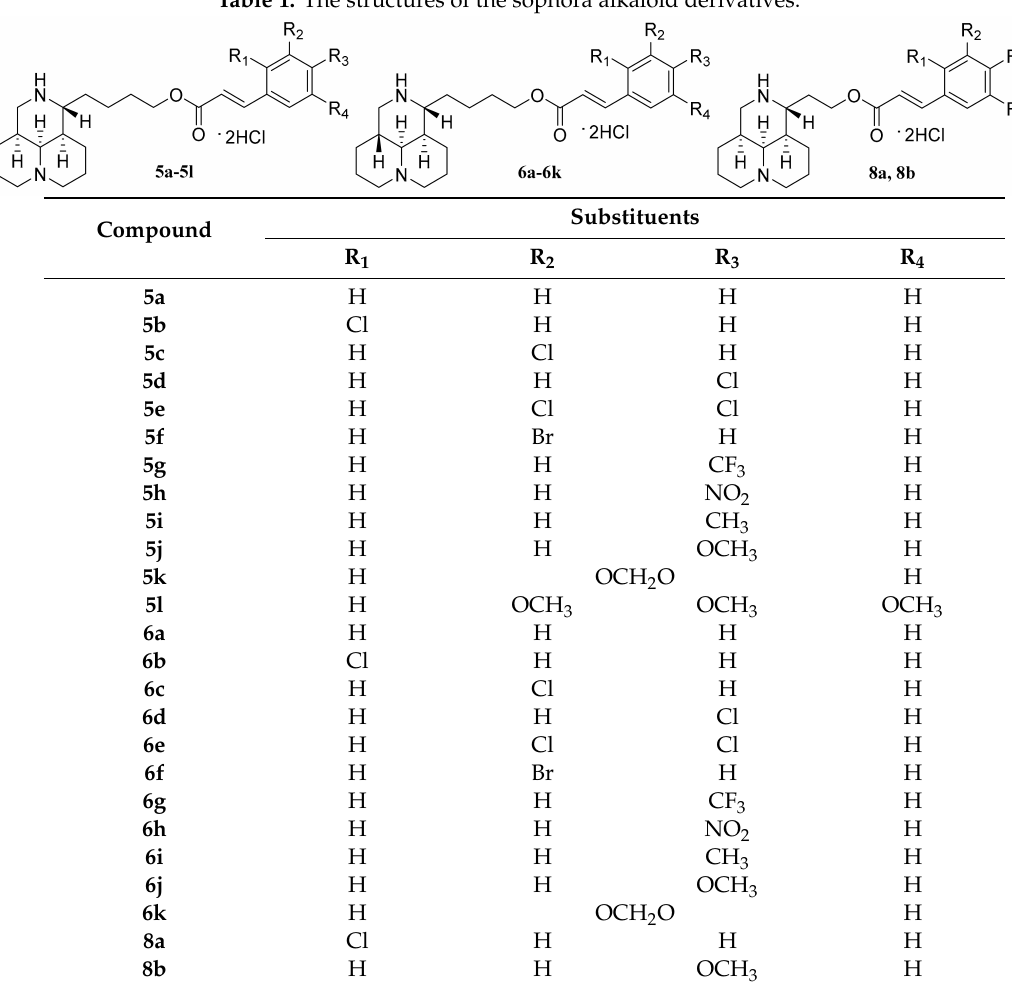
Table 1. The structures of the sophora alkaloid